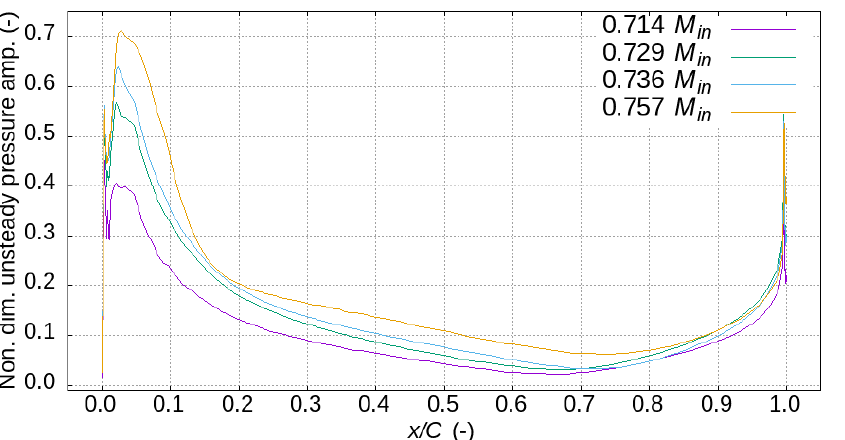
Figure 16. Profiles of Fourier-decomposed unsteady pressure amplitudes on the OGV pressure surface for varying M in